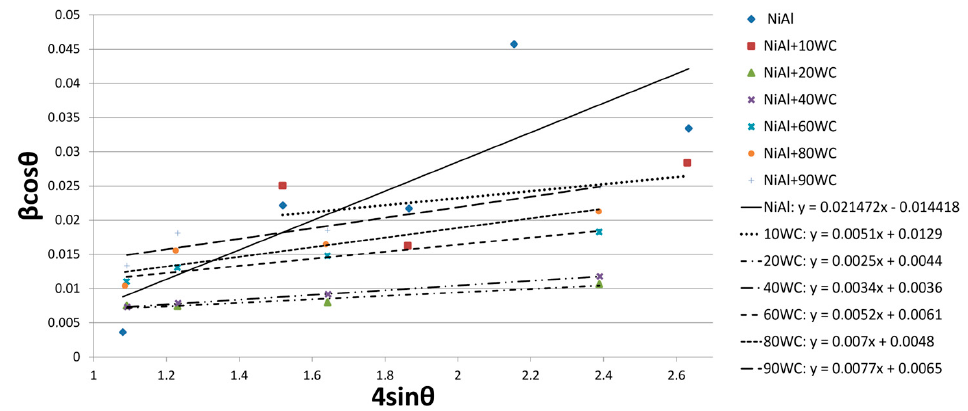
Figure 7. Linear Williamson–Hall plots with an obtained equation based on the XRD spectra of NiAl-xWC powder after 10 h of mechanical alloying.